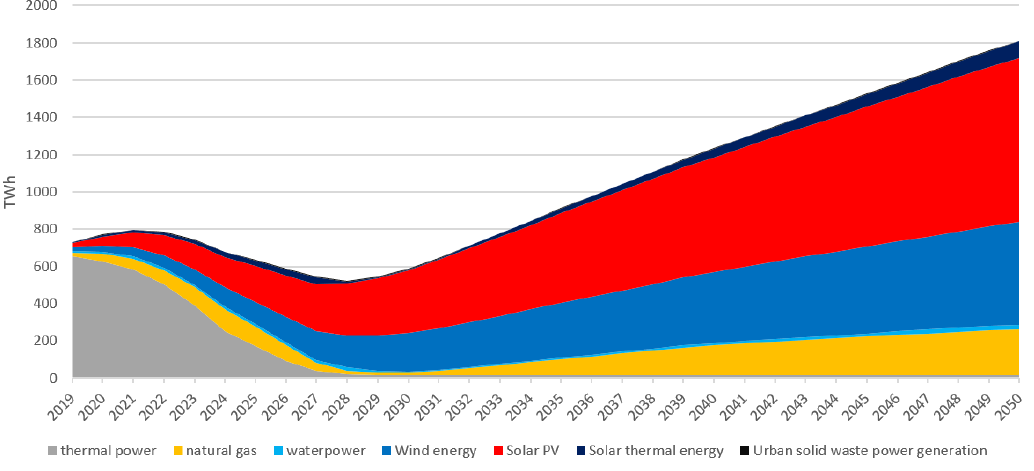
Figure 12. Power generation change in Inner Mongolia under carbon pricing scenario.